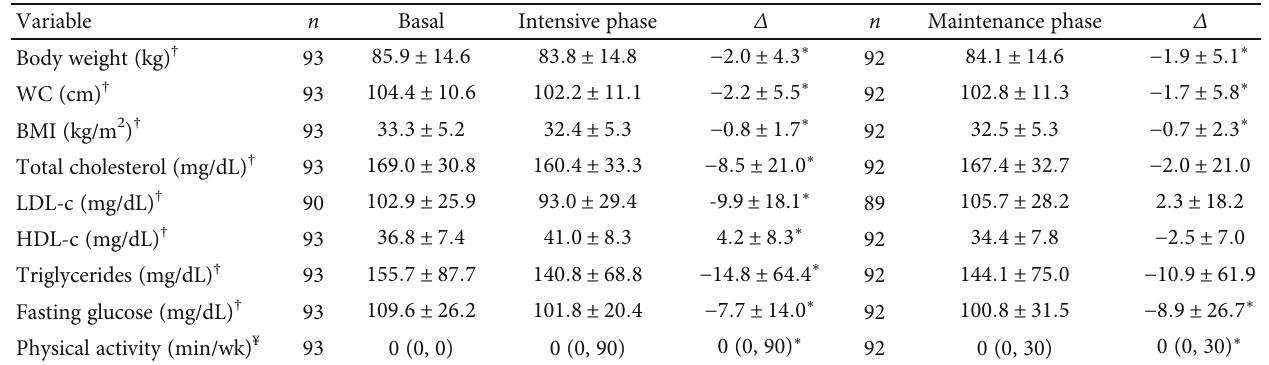
Table 3: Comparison of obesity parameters, metabolic markers, and physical activity of the participants (ITT). Variable n Basal